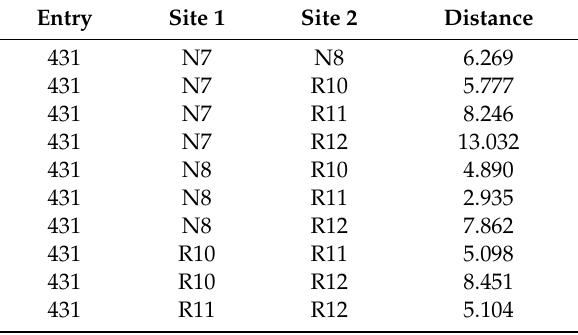
Table 2. The intersite distances between the selected pharmacophore hypotheses.